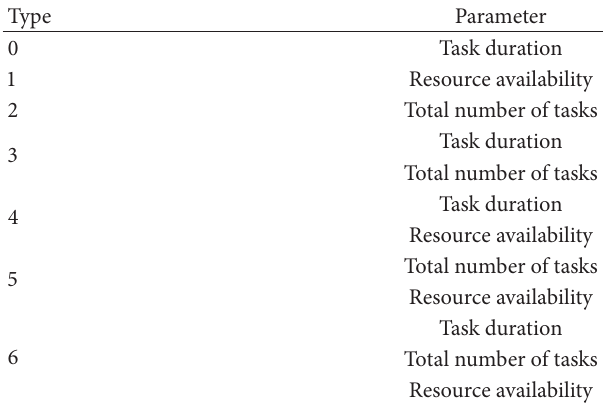
Table 2: Types of environmental changes.